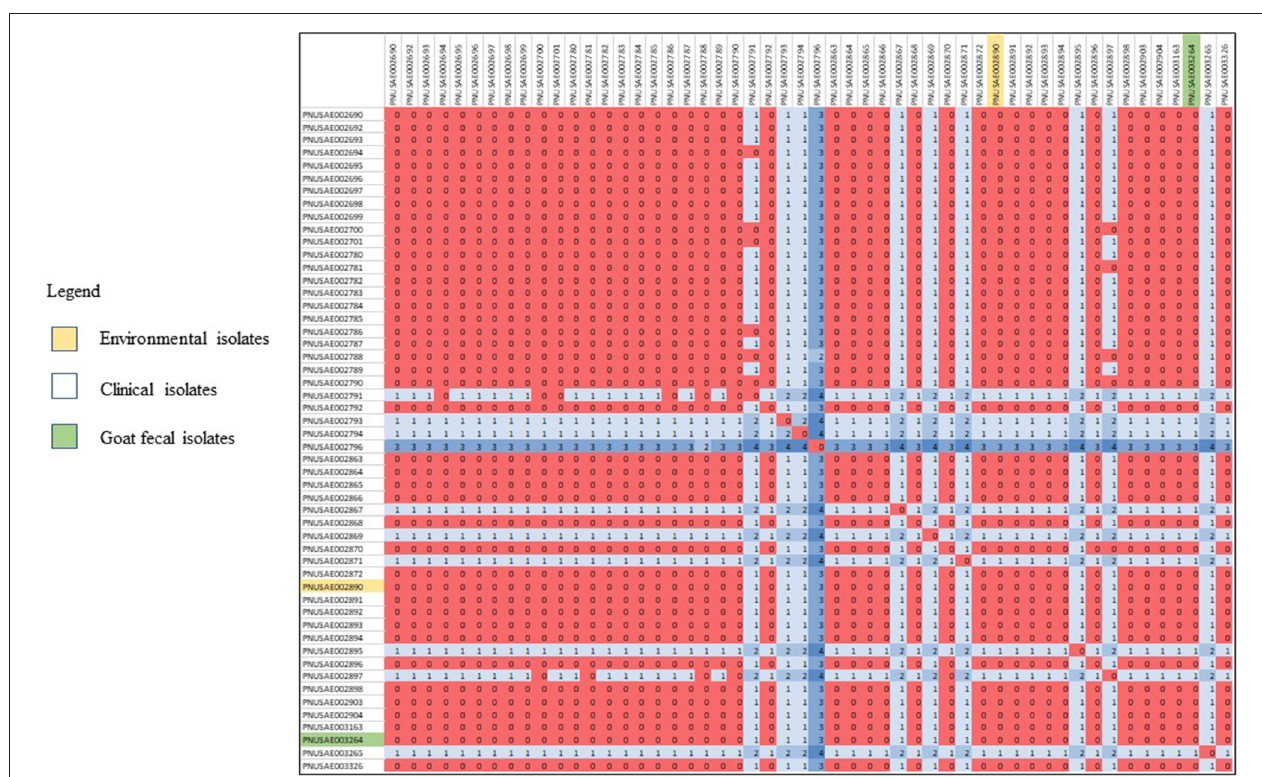
FIGURE 1 | High-quality single nucleotide polymorphism (SNP) analysis of E. coli O157 sequences ( n = 52) from isolates resulting from testing of clinical samples ( n = 50), goat feces ( n = 1), and an environmental sample from goat hay bedding ( n = 1) during an outbreak of illness linked to a goat farm in Connecticut. Clinical and environmental isolates were highly related genetically within 0–4 STCPs. The high-quality SNPanalysis had phages masked, an internal reference PNUSAE002903-CT -M4158-160428_filtered_chromosomes.fasta, and was generated with Lyve-SET version 1.1.4f. Reads were cleaned with CG Pipeline (options: –no-singletons). SNPs were called with Varscan, and Lyve-SET was run with the following options: minimum coverage − 20min, alternative fraction − 0.95, and allowed flanking − 5 bp.